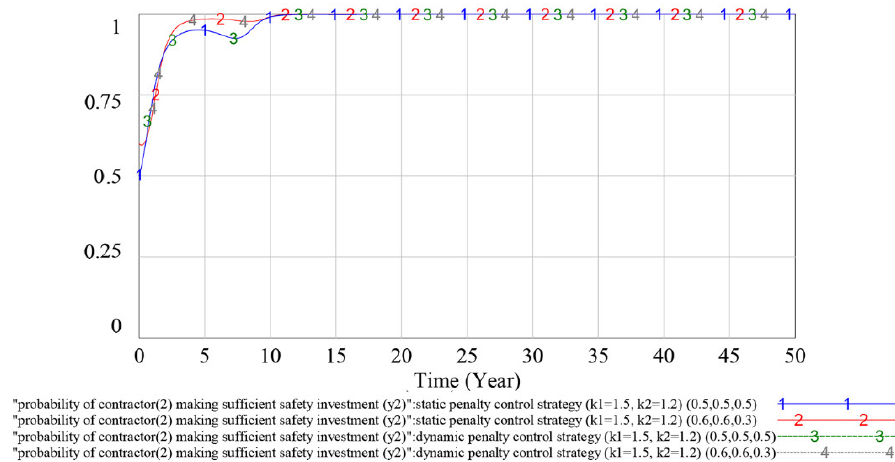
Figure 12. Influence of different initial values on contractor (2)’s strategy choices under different penalty control strategies.